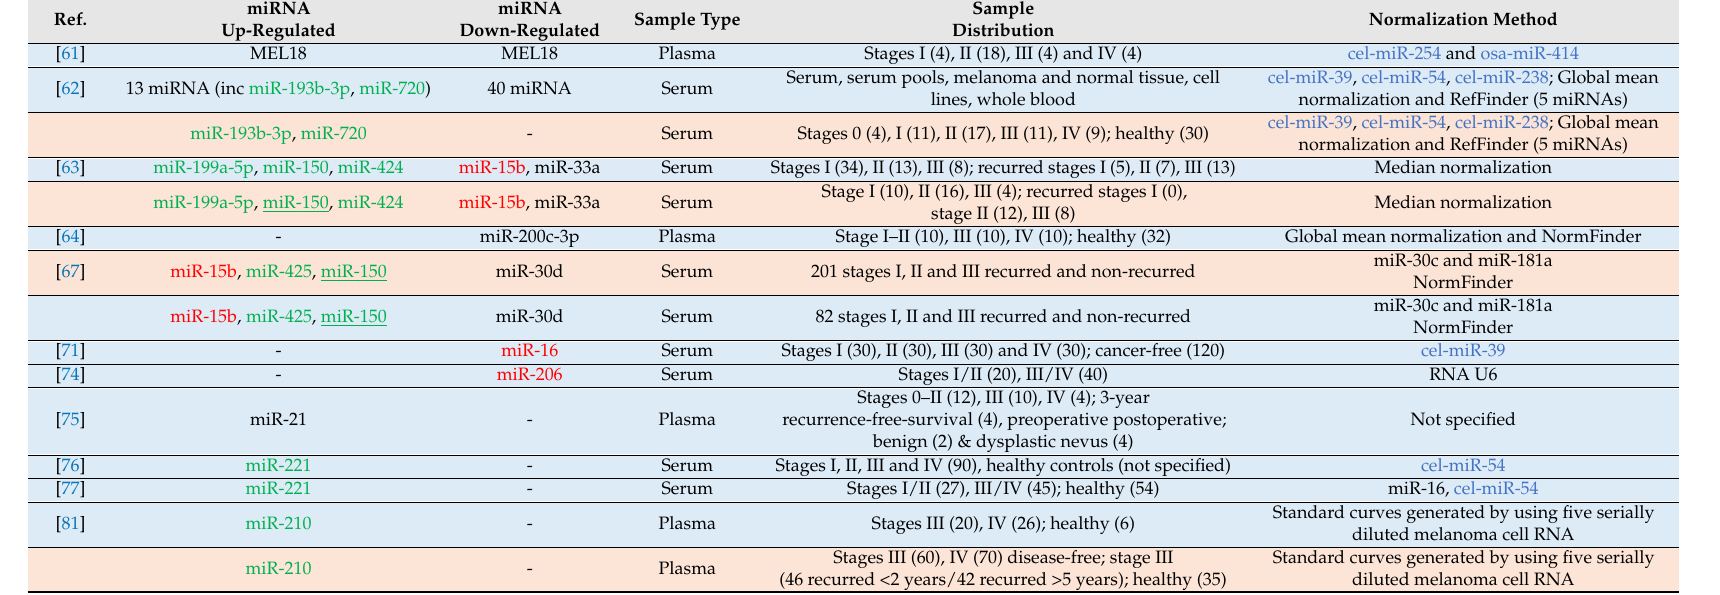
Table 2. Potential prognostic circulating miRNA biomarkers for melanoma. This table summarizes the miRNAs found to be differentially expressed in the circulation of metastatic melanoma patients compared to non-metastatic melanoma patients, and/or those whose up- or down-regulation correlates with poor prognosis, highlighting the technical variables that may lead to the lack of consistency between studies. Pastel blue rows refer to discovery/training patient cohorts. Pastel orange rows refer to independent validation patient cohorts. Stage 0 = Healthy controls. MiRNAs showing the same direction of change between multiple studies and/or have been verified using both a discovery and validation cohort are shown in green and those that additionally have used an acceptable normalization method and have been verified using an independent validation cohort are shown in green and are underlined. MiRNAs showing a different direction of change between studies are shown in red. Exogenous spike-in controls are shown in blue. Further details are given in Table S2.